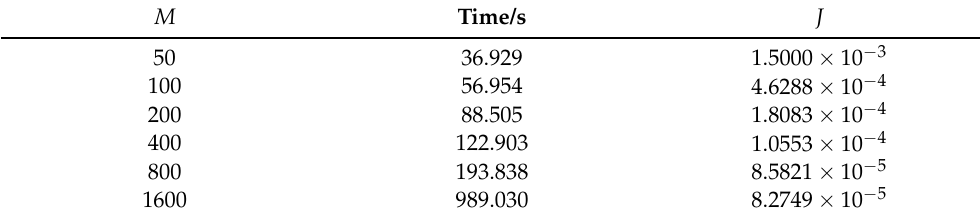
Table 1. Influence of different M values on identification time and accuracy.